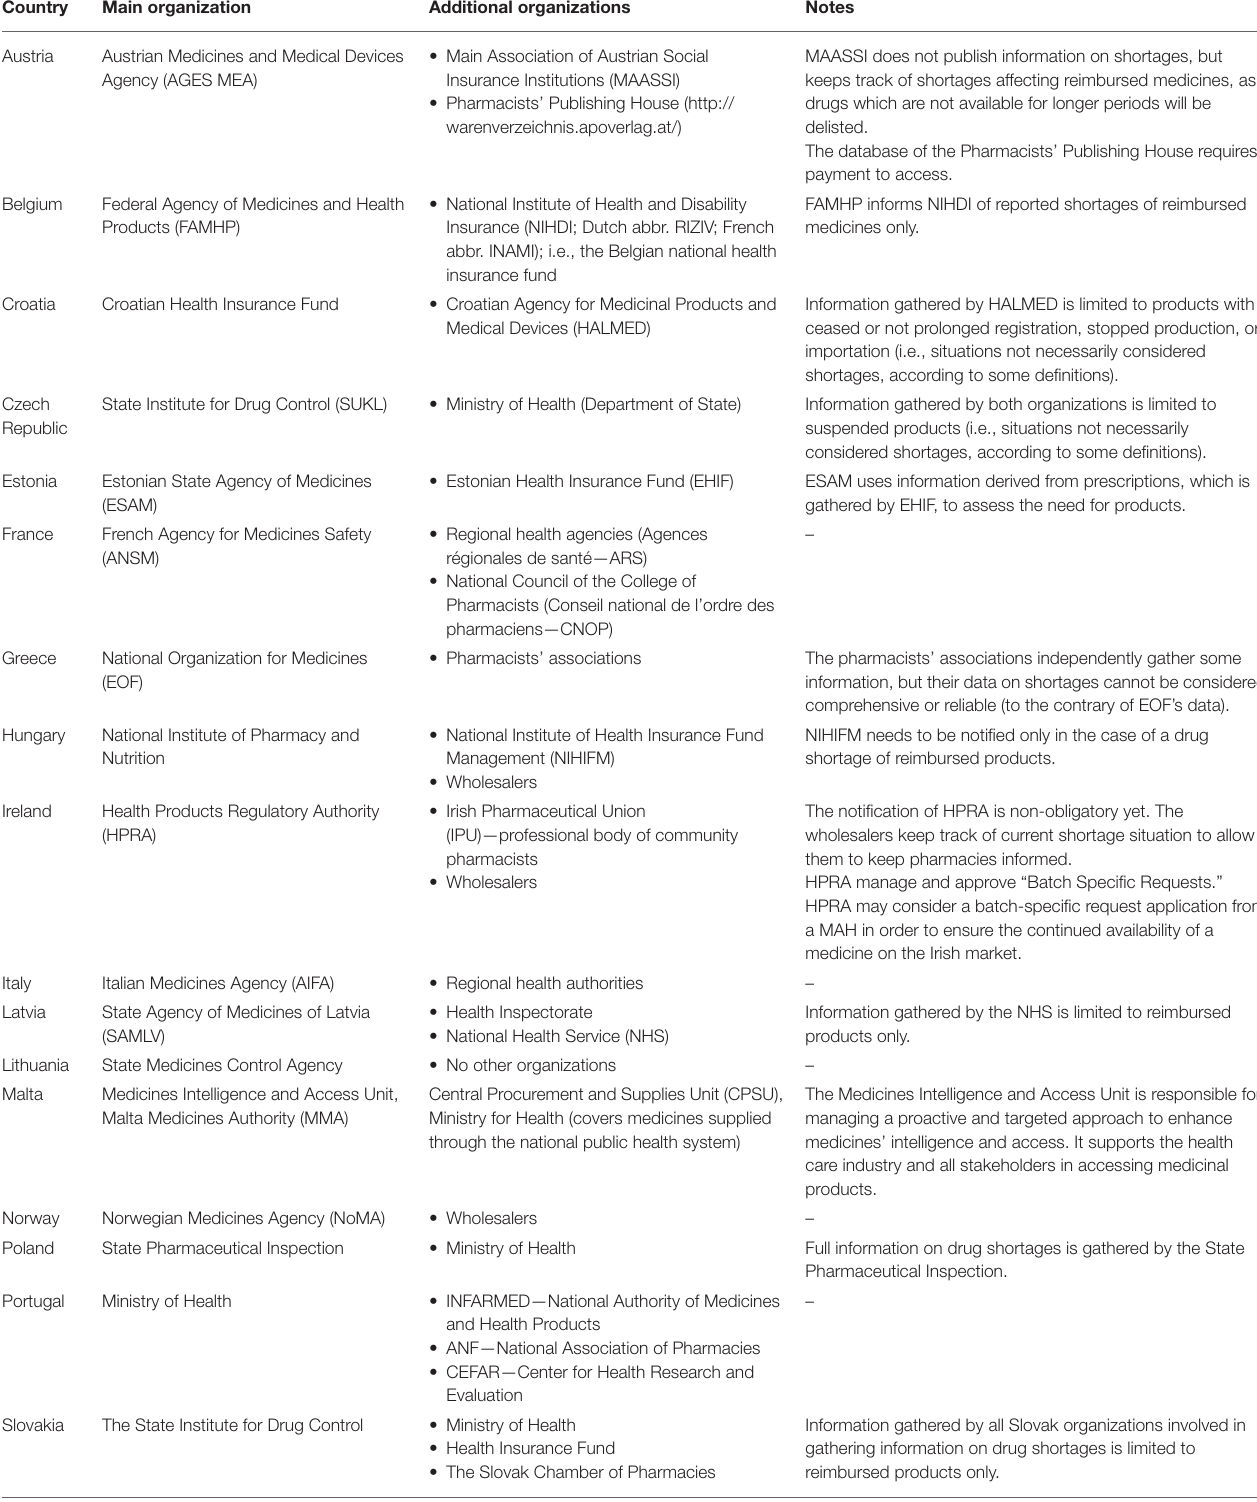
TABLE 3 | Organizations involved in gathering information (“information hubs”) on drug shortages in countries of the European Union and the European Free Trade